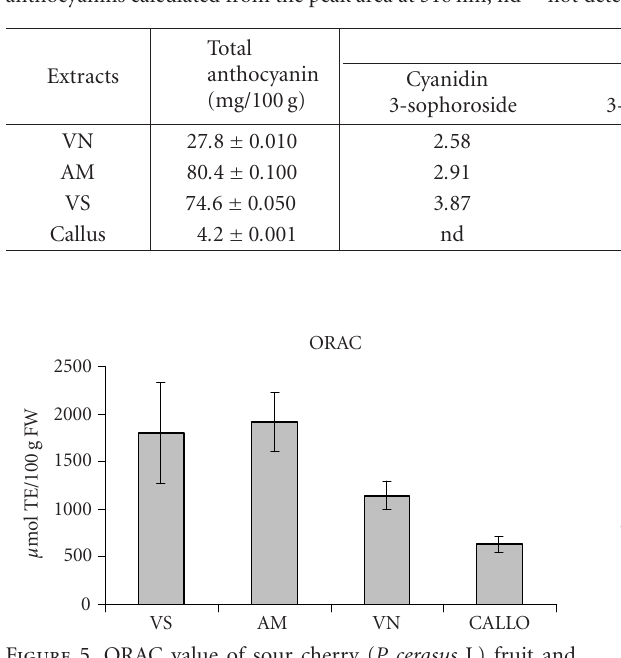
Table 1. Total anthocyanin content and composition of sour cherry ( P cerasus L) fruit extracts of Visciola Ninno, Amarena Mattarello, and Visciola Sannicandro cultivars and of callus culture extract. Anthocyanin composition was determined as a percentage of total anthocyanins calculated from the peak area at 518 nm; nd = not detected.